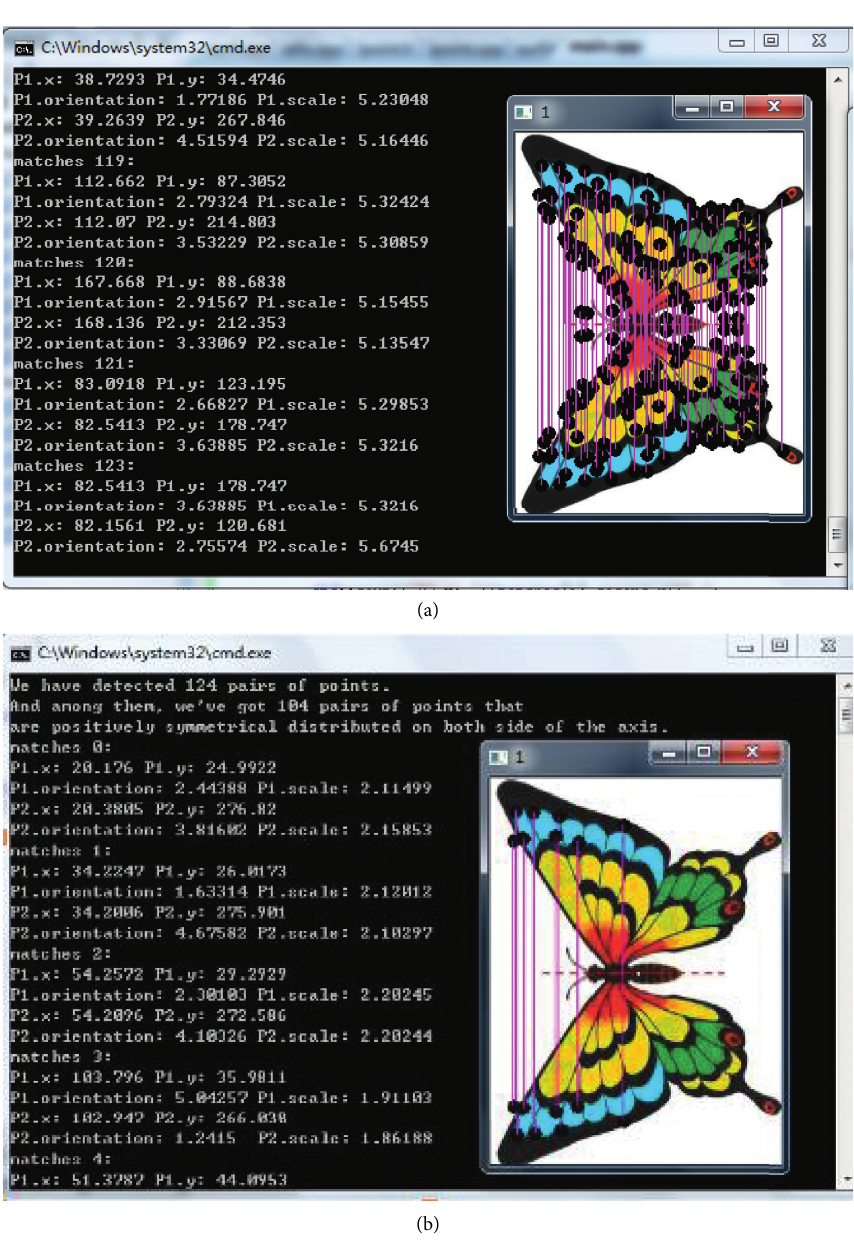
Figure 17: Symmetrical SURF points matching results of butterfly specimens’ images.